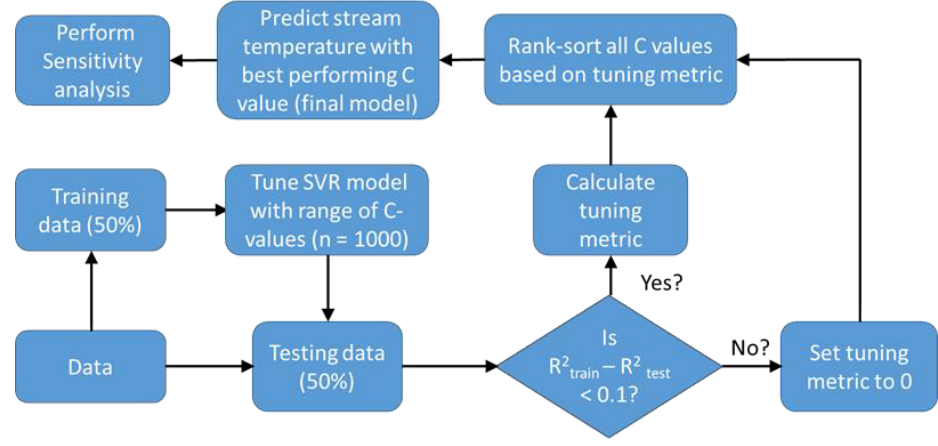
Figure 4. Flowchart showing the SVR process used in this study.